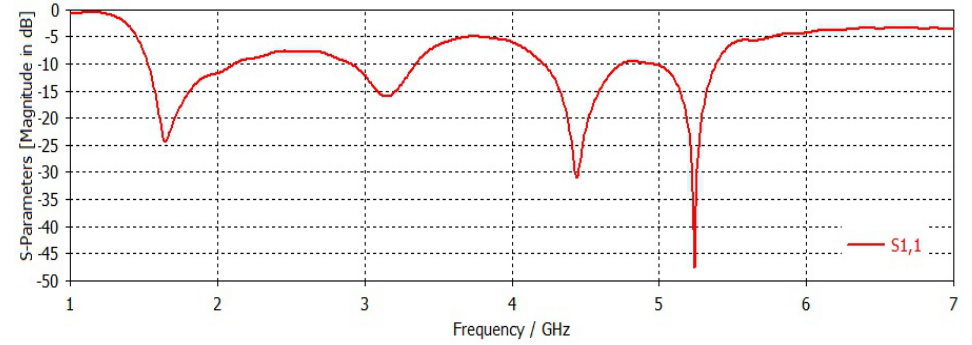
Figure 2. The simulated input reflection coefficient of the antenna.